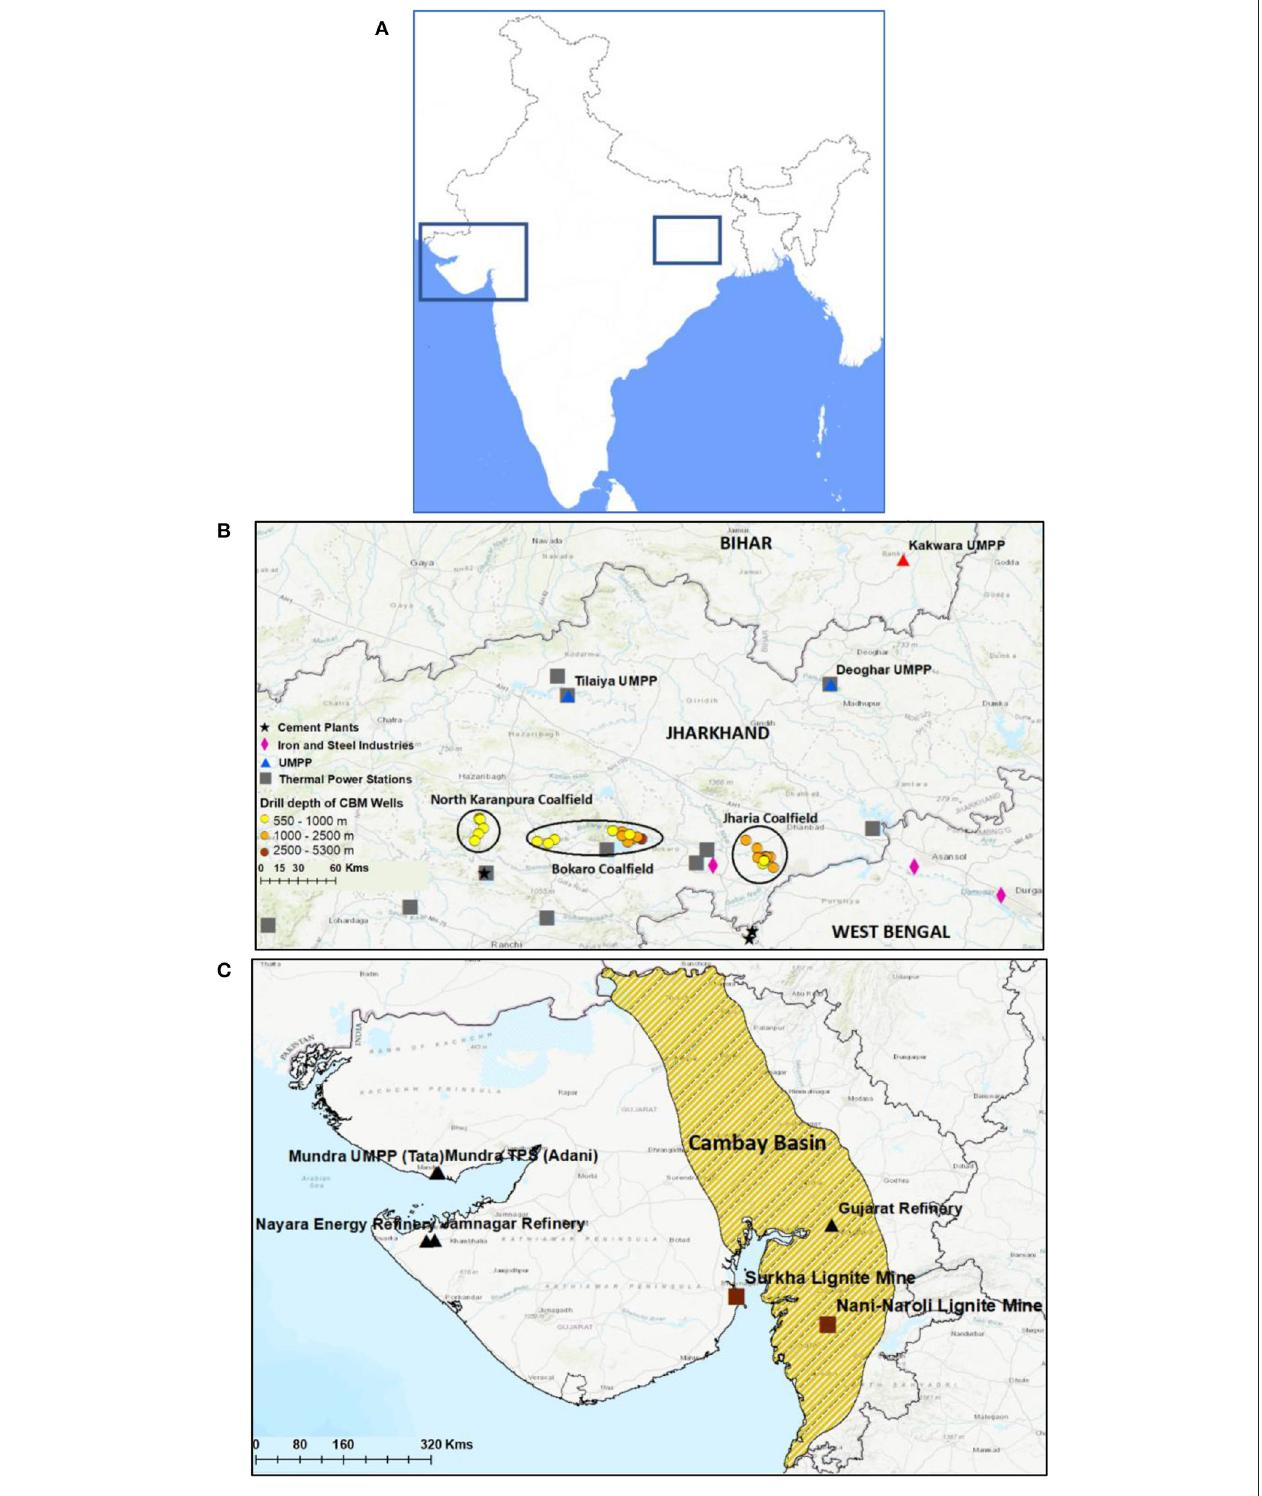
FIGURE 2 | Prospective CCS hubs could be centered around unconventional formations on the map of India (A) with insets showing eastern (B) and western India (C) . UMPP: Ultra-mega power plant.